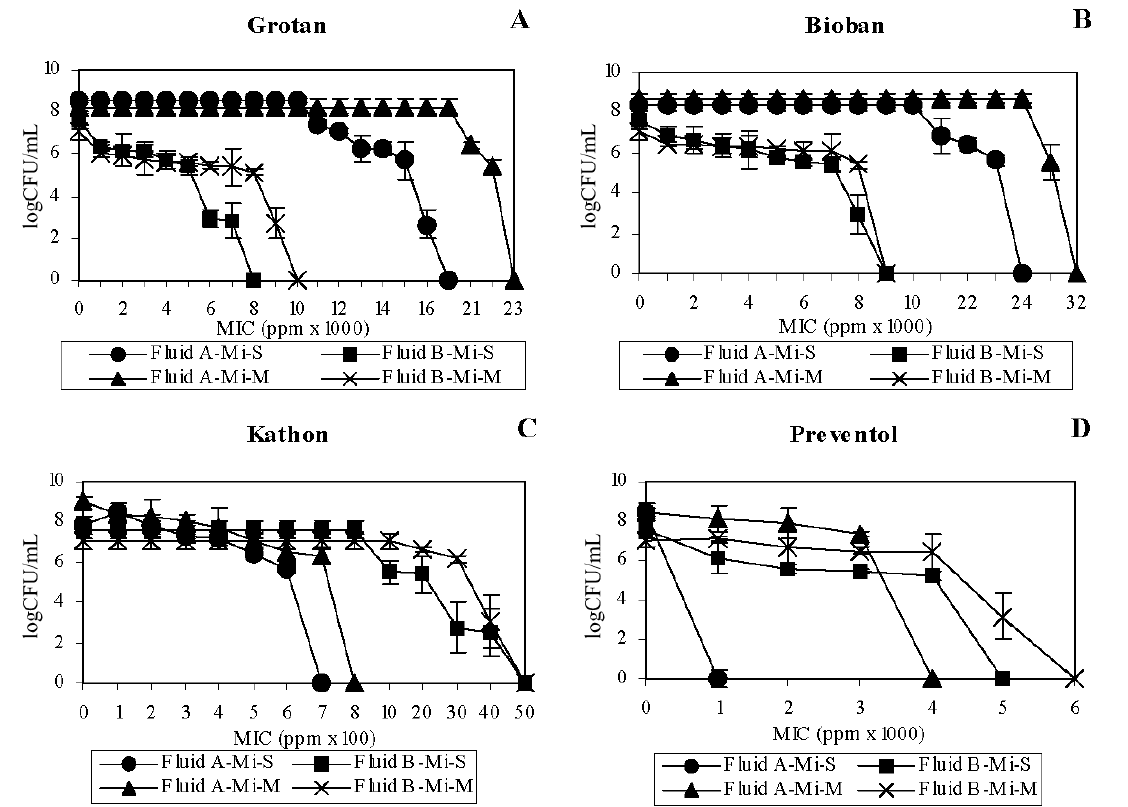
Figure 1. Effect of fluid type on biocidal efficacy toward M. immunogenum . Two different semi-synthetic fluid types (Fluid A and Fluid B) were used to investigate the biocidal activity of four individual test biocides namely, Grotan (Panel A ), Bioban (Panel B ), Kathon (Panel C ) and Preventol (Panel D ) in terms of minimum inhibitory concentration (MIC), either in single culture (pure) suspension or in mixed culture suspension (1:1 ratio with P. fluorescens ) of M. immunogenum . The MIC values were based on 100% killing of the test organism and are means of the triplicates. The test organism was exposed to varying levels of the individual biocides for 60 min each in the two test MWF matrices.